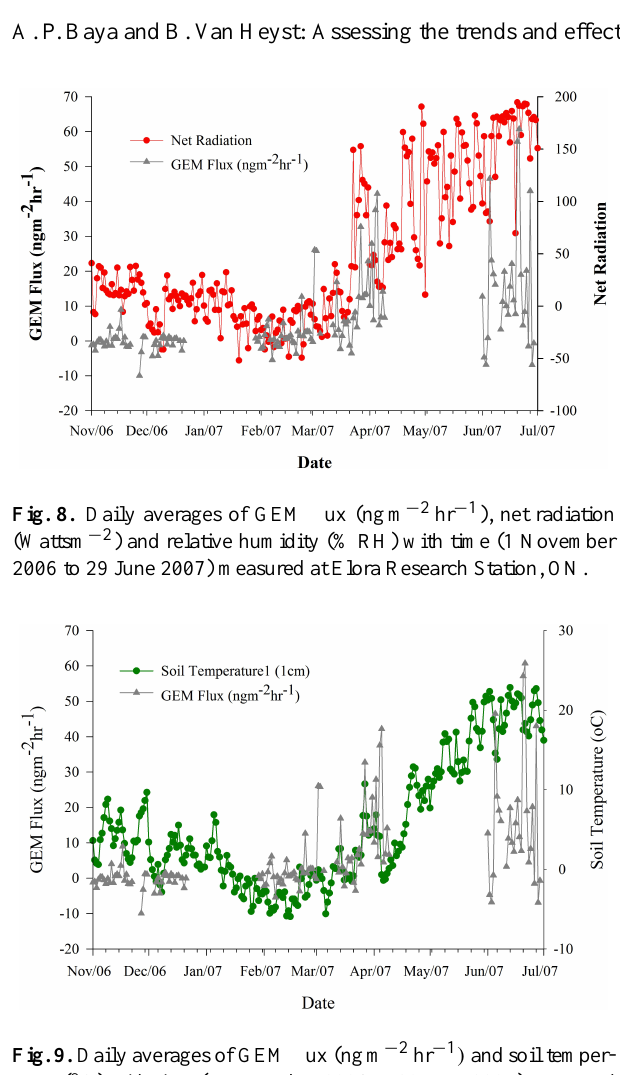
Fig. 9. Daily averages of GEM flux (ngm − 2 hr − 1 ) and soil temper- ature ( ◦ C) with time (1 November 2006 to 29 June 2007) measured at Elora Research Station, ON.